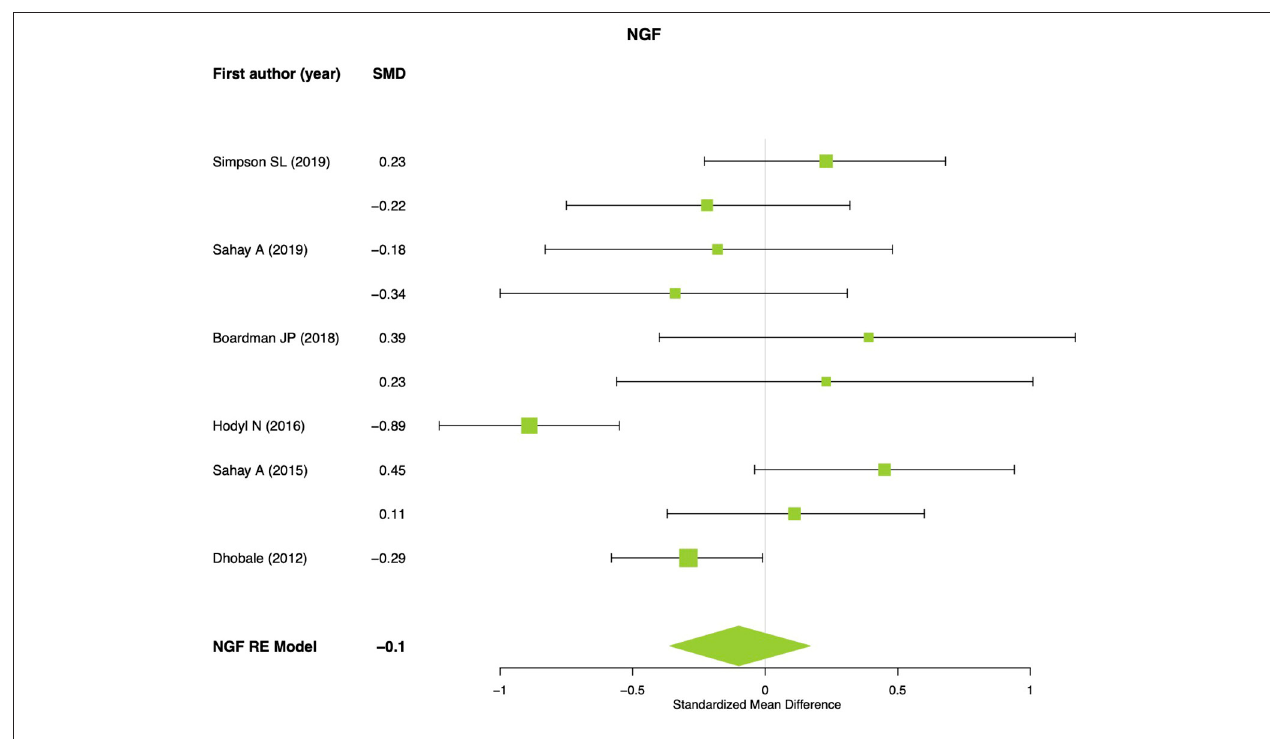
FIGURE 2 | NGF meta-analysis. RE, random effects model.